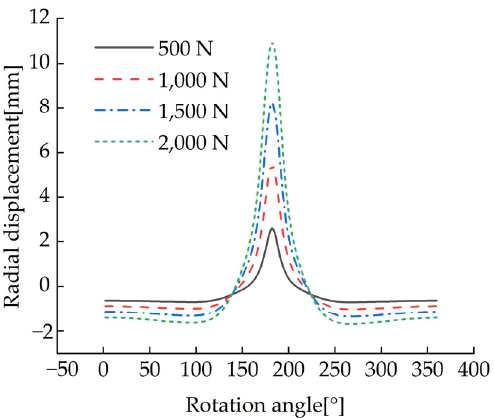
Figure 16. Variation curve of radial displacement under different loads.